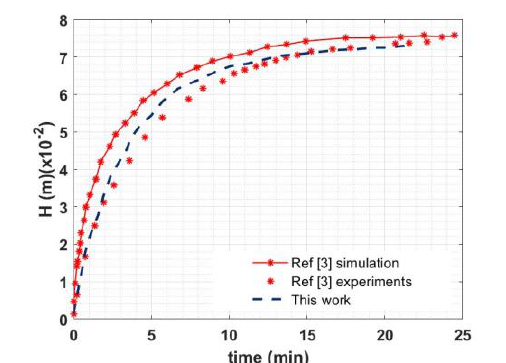
Fig. 6 Time evolutions of the height (H) of the bed of